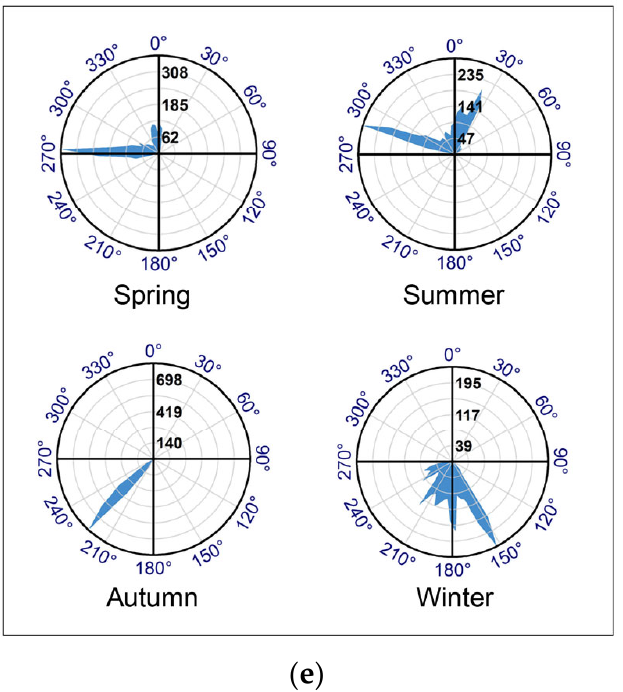
Figure 3. Continuous wind field in the research area during the four seasons: ( a ) spring, ( b ) summer, ( c ) autumn, and ( d ) winter; ( e ) shows wind rose diagrams illustrating wind direction and wind speed for four seasons.